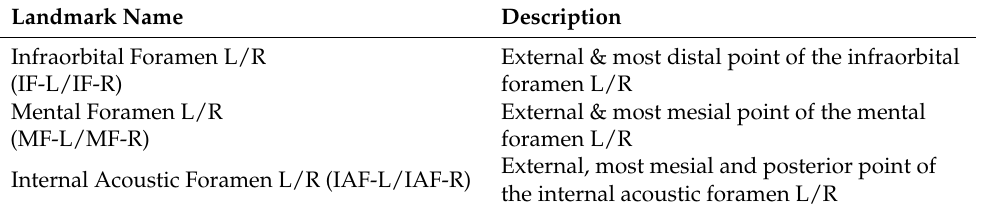
Table 3. Definition of “dental” landmarks localized in our study (FDI World Dental Federation notation for teeth